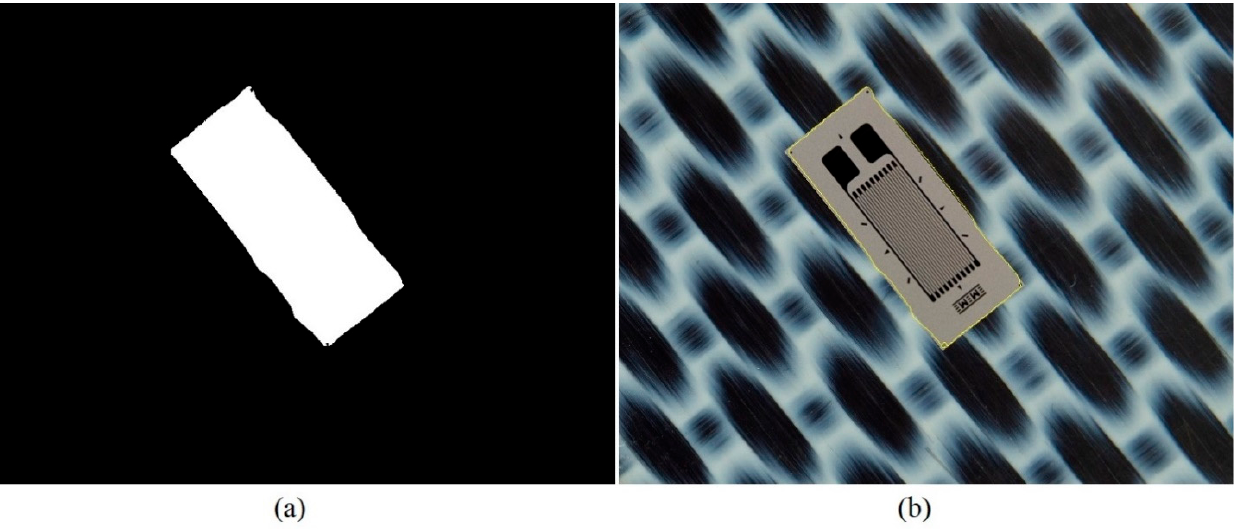
Figure 6. Final results obtained from post-processing in step 5: ( a ) SG mask and ( b ) SG contour (yellow) superimposed on the acquired image.